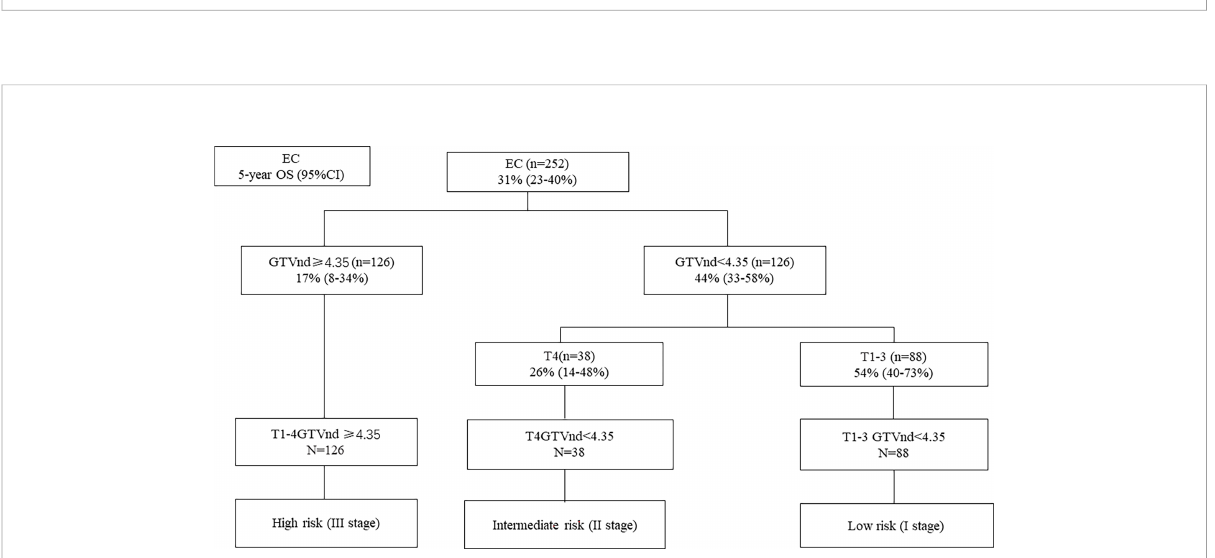
FIGURE 2 Recursive partitioning analysis (RPA) for OS in ESCC patients based on GTVnd and T stage.